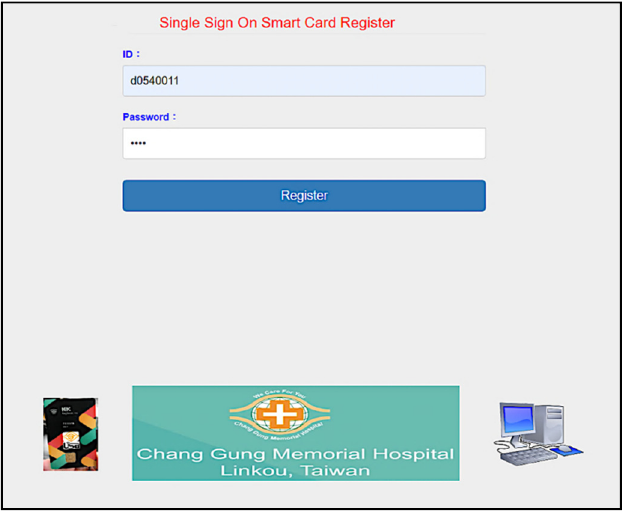
Figure 8. User registration.